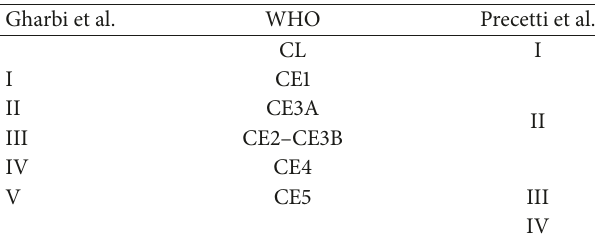
Table 1: Comparison among Gharbi’s, WHO, and Precetti’s classifi- cations of the echinococcal